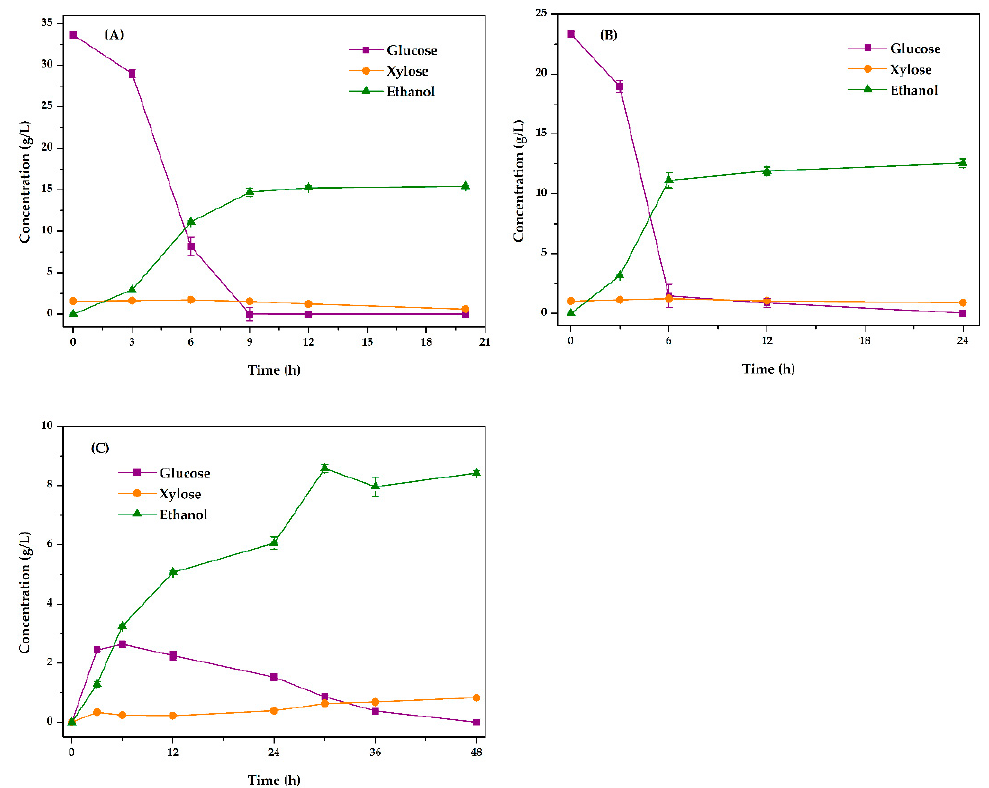
Figure 3. The curves of ethanol growth and fermentable sugars consumption by different fermenta- tion methods. ( A ) SHF, ( B ) SSCF, and ( C ) SSF.